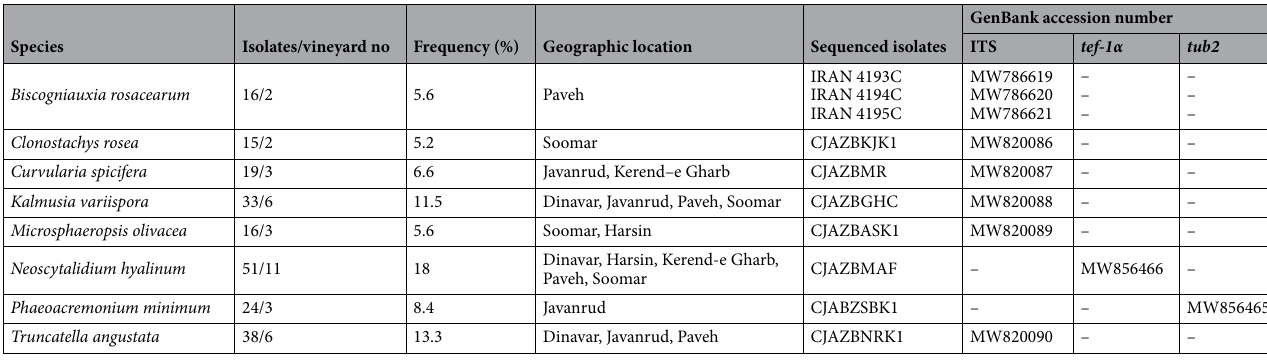
Table 1. Isolates number, frequency, geographic location and culture collection and GenBank accession numbers of fungal species identified in this